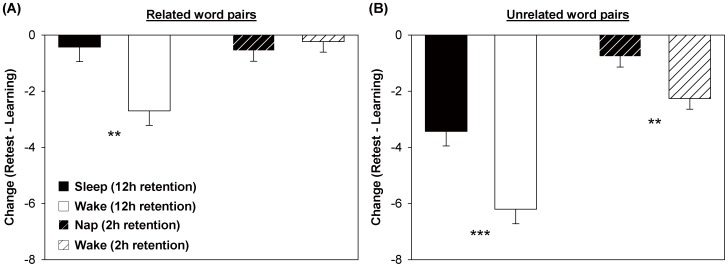
Change in paired-associate performance across the retention interval.
(
A
) Forgetting of semantically related word pairs over a 12-hour retention interval was reduced by nocturnal sleep (black bar) relative to wakefulness during the day (white bar). In contrast, a daytime nap (black hatched bar) had no such effect on forgetting over a 2-hour retention interval compared to wakefulness (white hatched bar). (
B
) For semantically unrelated word pairs, both nocturnal sleep and daytime napping attenuated forgetting over the retention intervals. ** P<0.01; *** P<0.001.